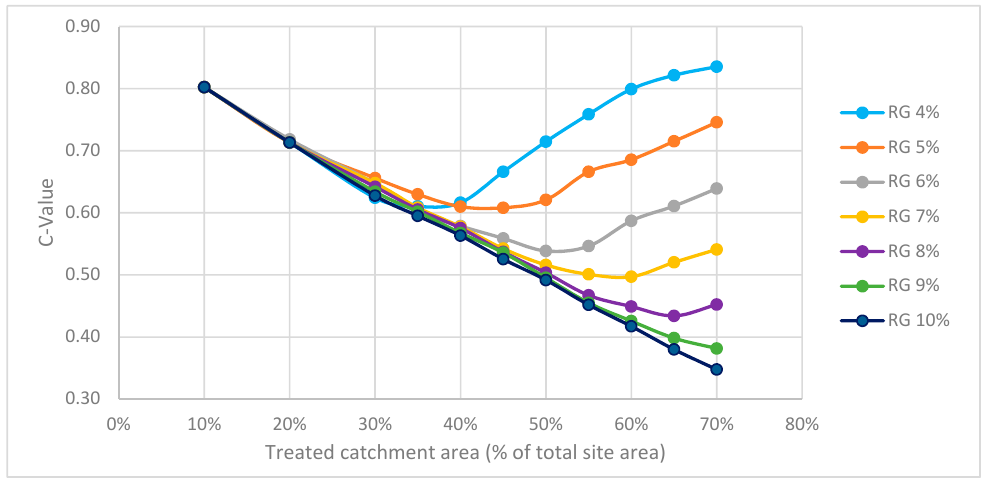
Figure A6. Commercial precinct results of effective C-value versus treated catchment area for various rain garden sizes.